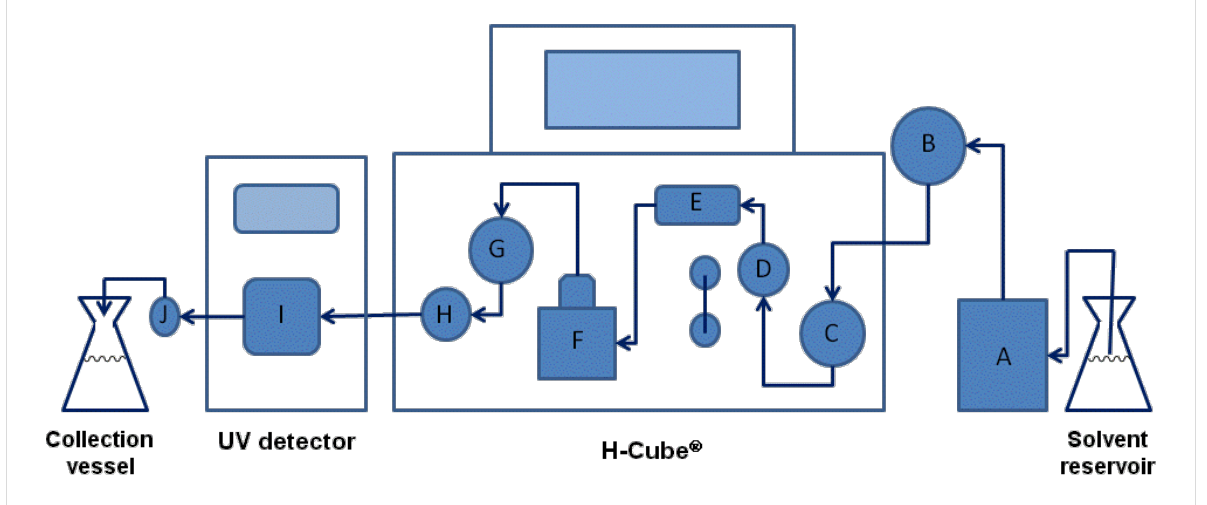
Figure 1: SAH 3 schematic with injector port and UV detector. Components: (A) pump; (B) six-position manual injector port; (C) inlet pressure sensor; (D) gas–liquid mixing chamber; (E) bubble detector; (F) CatCart ® holder; (G) outlet pressure sensor; (H) back pressure regulator; (I) UV flow cell; (J) 10 bar fixed in-line back pressure regulator. Arrows indicate the flow